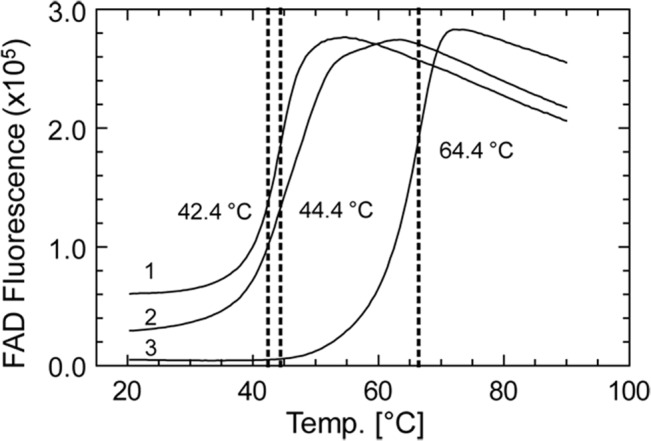
Effect of the redox state of FAD and of norfluorazon on the stability of PDS-His6.Thermo-FAD measurements were carried out in a RealTime-PCR instrument using the SYBR-Green Channel (Exc = 488 nm; Em = 520 nm). Trace 1; PDS-His6 isolated in the absence of norflurazon containing FADox. Trace 2; PDS-His6 isolated in the absence of norflurazon containing FADox after addition of 50 μM norflurazon, Trace 3; PDS isolated in the presence of 50 μM norflurazon containing FADred.